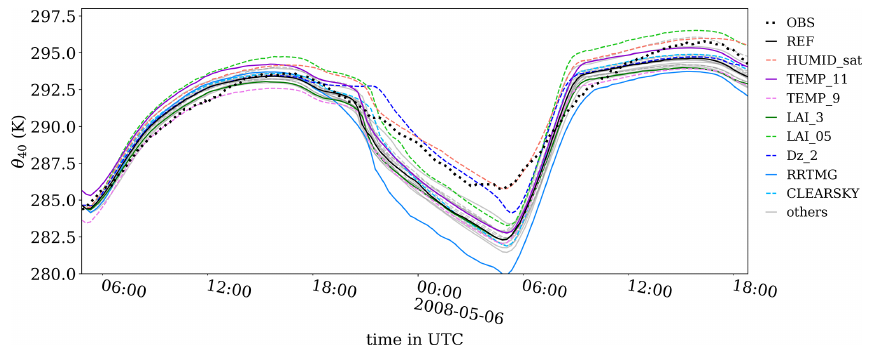
Figure 11. Time series of mean potential temperature at 40m as measured at Cabauw (OBS) and for all cases listed in Table 5. Only case REF and some relevant cases are highlighted; all others are shown in gray.